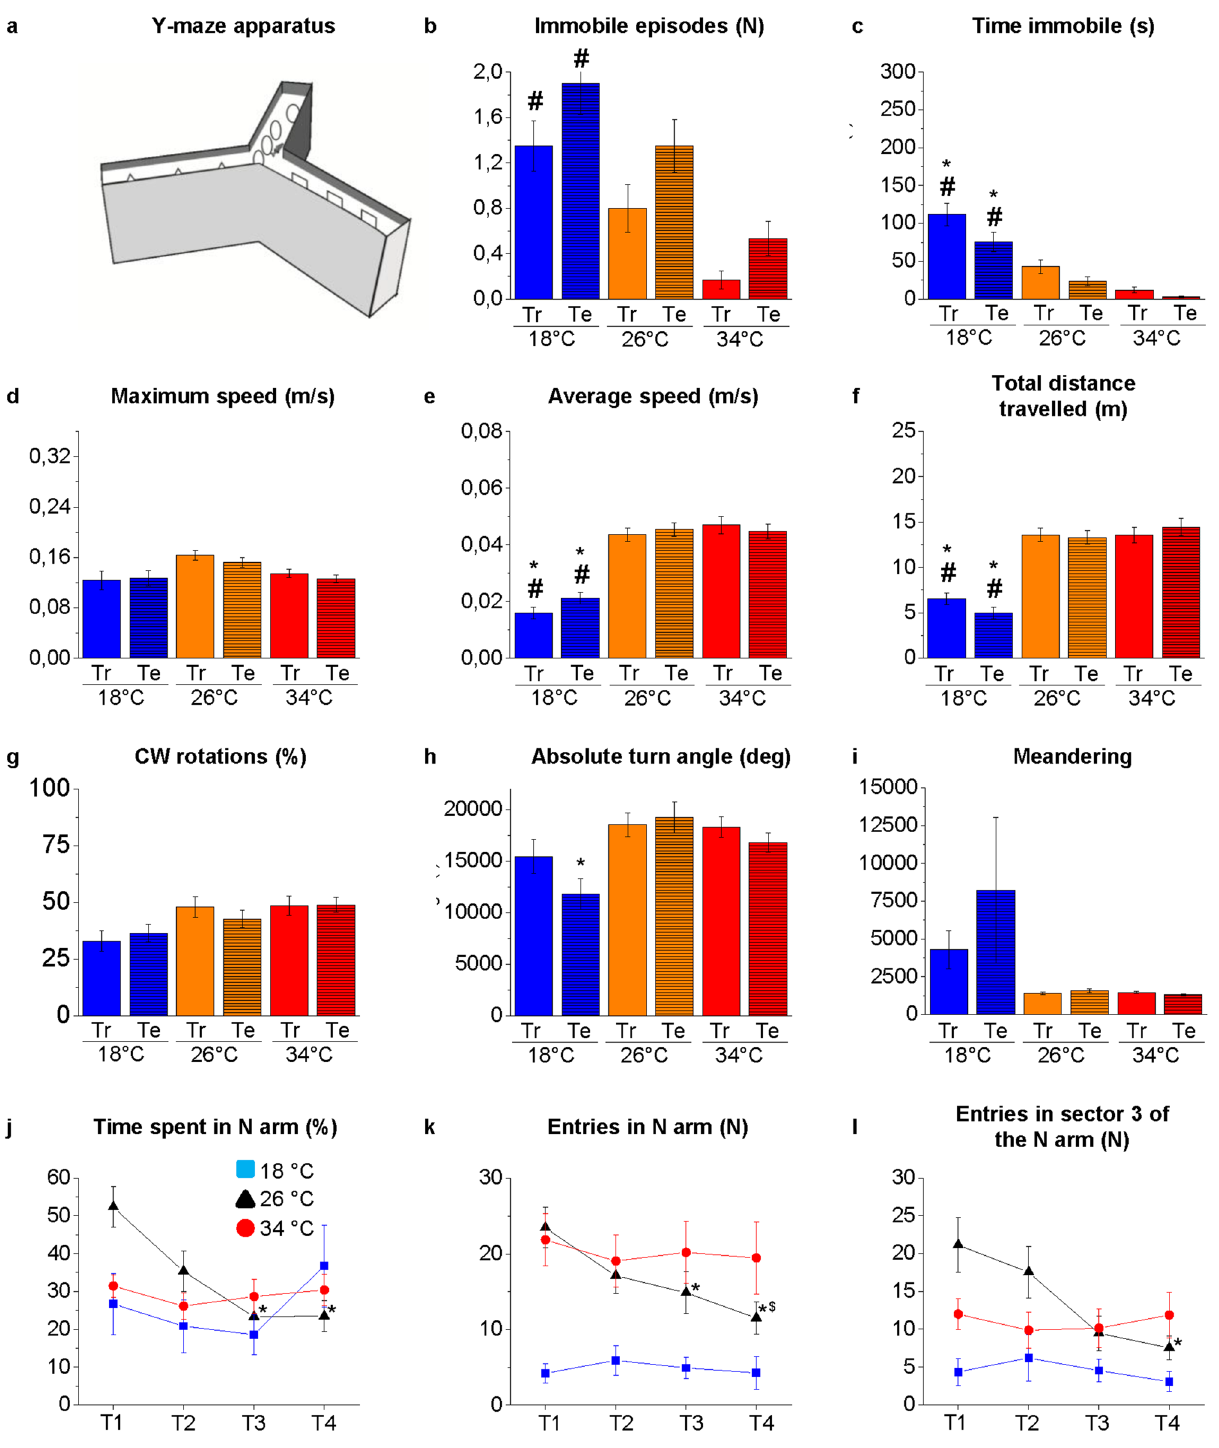
Figure 5. Behavioural response to thermal treatment on the Y-Maze test observed in the training (Tr) and testing (Te) phases. Schematic representation of the apparatus ( a ). Swimming activity and behaviour measured as immobile episodes ( b ), time immobile ( c ) maximum speed ( d ), average speed ( e ), total distance travelled ( f ), clockwise (CW) rotations expressed as percentage of total rotations ( g ), absolute turn angle ( h ), and meandering ( i ). The data were analysed by two-way ANOVA with post hoc Bonferroni correction. P ≤ 0.05, °, intra-temperature difference between Tr and Te; *, intra-phase differences between 18 and 26 °C; #, intra-phase differences between 18 °C and 34 °C; @ intra-phase differences between 34 °C and 26 °C. P values are reported in Table S6. Novel environment exploration T1–T4. Time spent in N arm ( j ), number of entries in N arm ( k ) and number of entries in sector 3 of the N arm ( l ). The data were analysed by two-way repeated measures ANOVA with post hoc Bonferroni correction. P ≤ 0.05, *, compared to T1,$, compared to T2. P values are reported in Table S7. Square, triangle and circle indicate 18 °C, 26 °C, and 34 °C respectively. N =